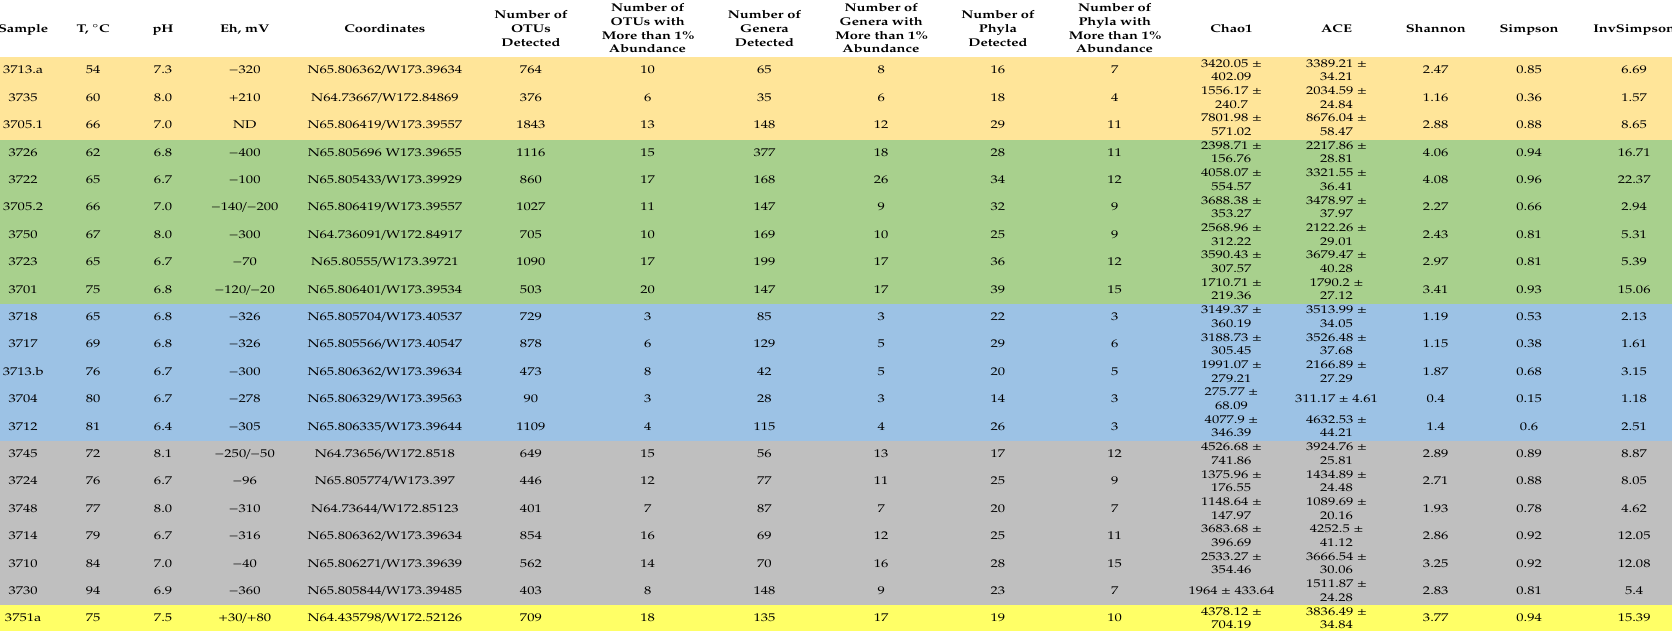
Table 1. General characteristics of the Chukotka hot springs and alpha diversity metrics of microbial communities